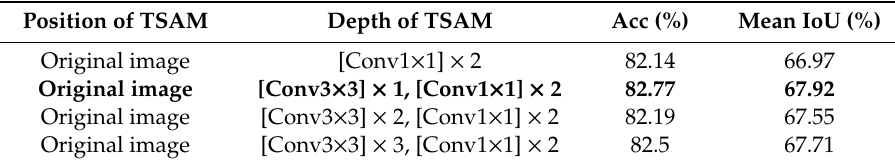
Table 3. Performance comparison for TSAMs with di ff erent depths.